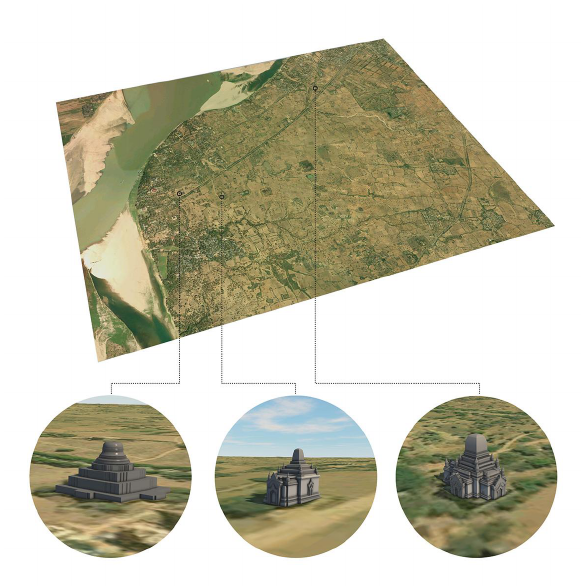
Figure 8. GIS of Old Bagan incorporating the model at LOD (3) of the temples: Myin-pya-gu, Loka-hteik-pan, and